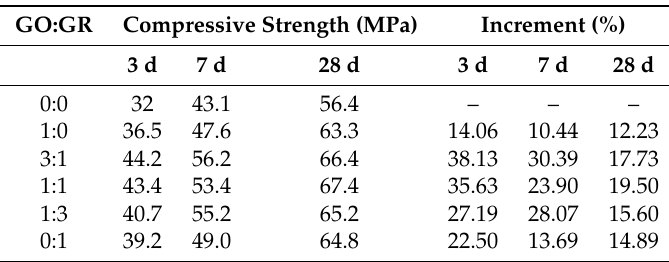
Table 4. Compressive strength of cement mortars incorporating GO / GR